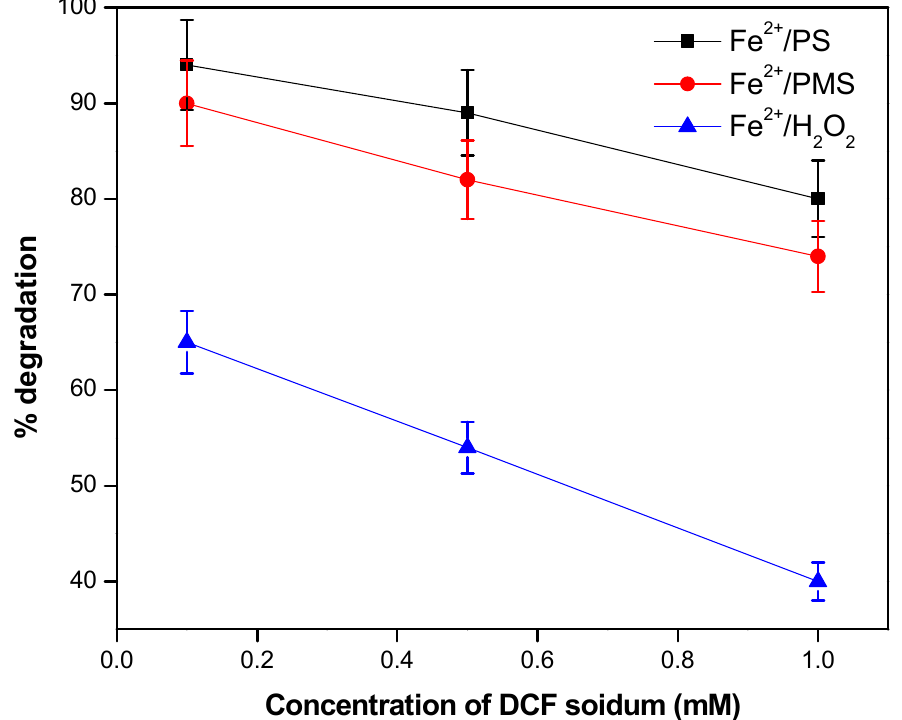
Figure 3. The effect of the initial concentration of DCF sodium on the degradation efficiency of DCF by the Fe 2+ /H 2 O 2 , Fe 2+ /PS and Fe 2+ /PMS systems. Reaction conditions: [DCF sodium] 0 = 0.1–1.0 mM, [Fe 2+ ] 0 = 0.5 mM, [H 2 O 2 ] 0 = [PS] 0 = [PMS] 0 = 10 mM, pH =